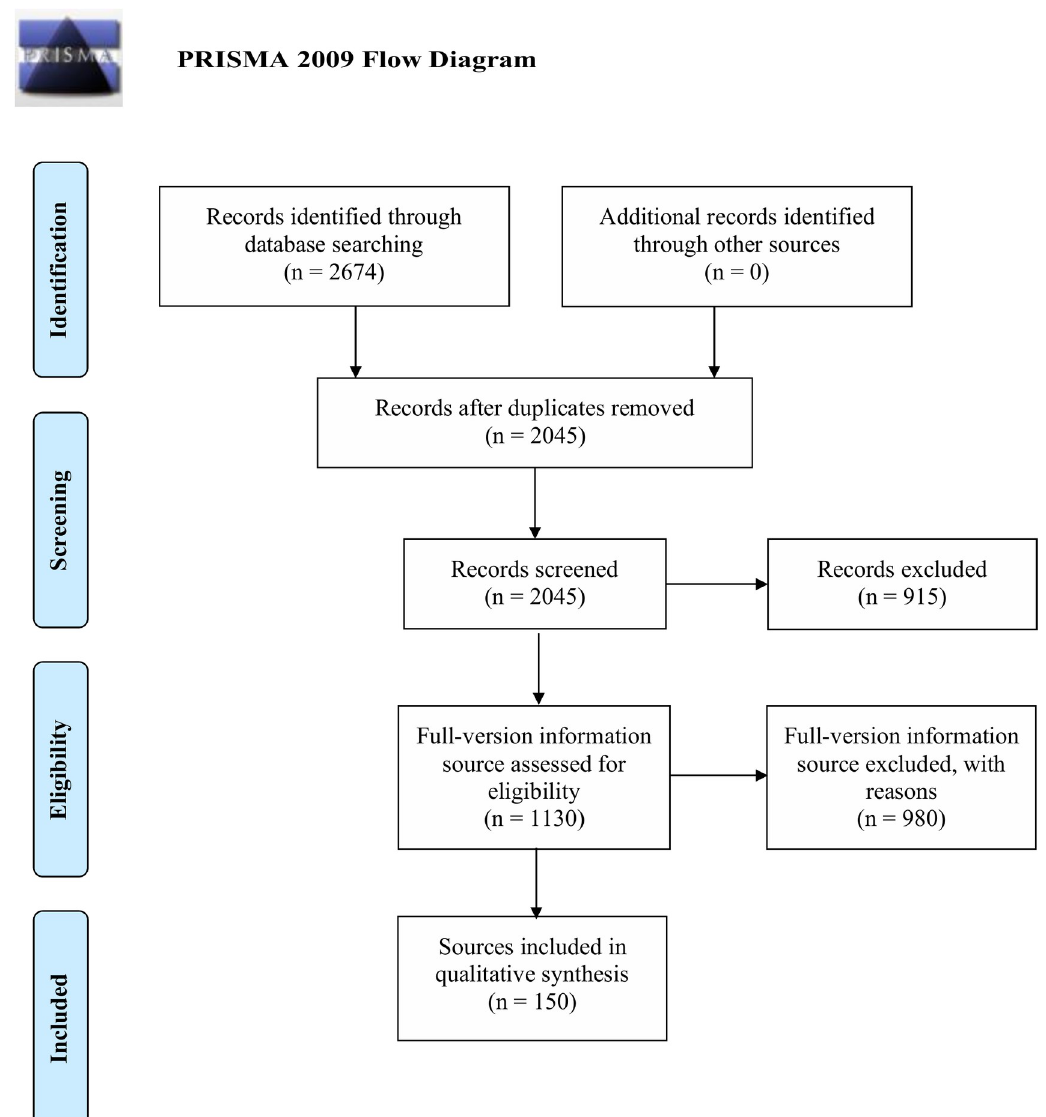
Fig 1. PRISMA (Preferred Reporting Items for Systematic Reviews and Metanalyses) flow diagram of search strategy. The process of identifying the educational resources that met inclusion criteria from databases illustrated as a flow diagram.